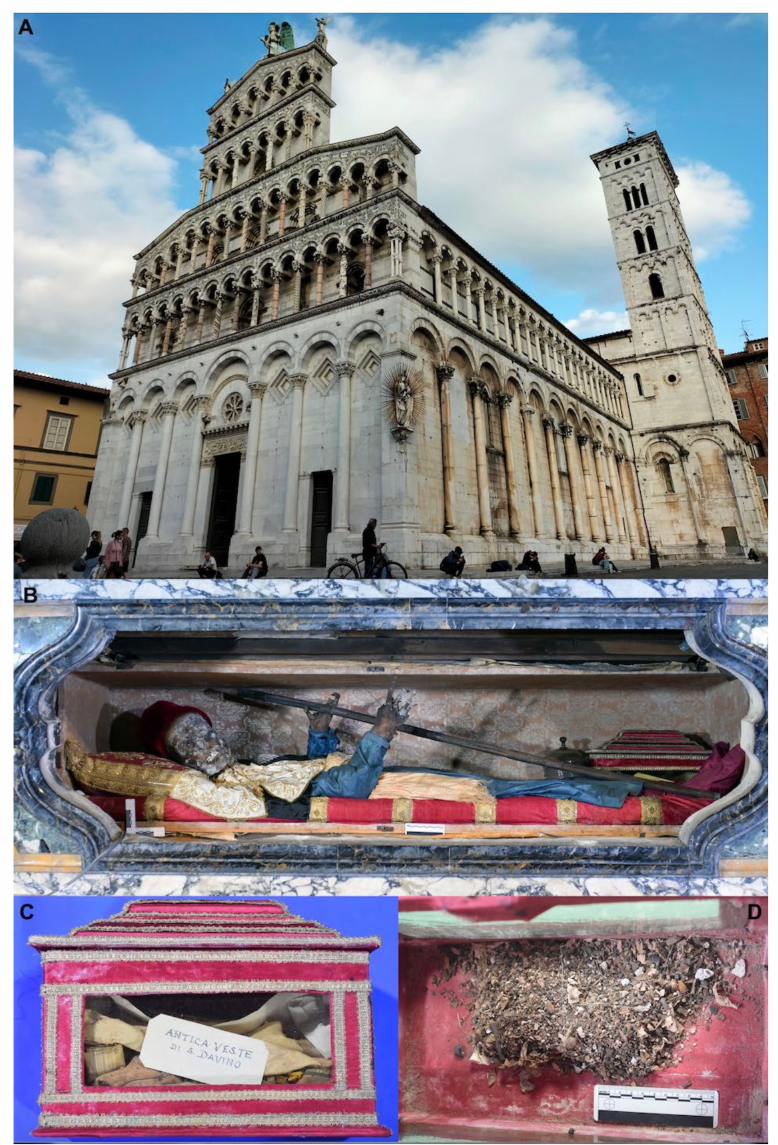
Figure 1. ( A ) External view of the magnificent church of Saint Michele in Foro (Lucca, Central Italy), where the body of Saint Davino Armeno is preserved ( B ). Whole view ( C ) and internal detail ( D ) of the small box kept in the Saint Davino reliquary, containing the remains of ancient fabrics and material made up of powders collected during the ancient canonical reconnaissance of the body, which were done in 1547, 1592, 1646, and